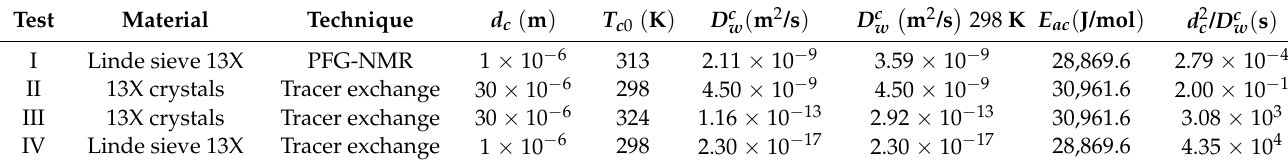
Table 3. Intracrystalline diffusivities for samples with different crystal sizes and average pore diameter of 7.4 Å and values of recalculated D c w at 298 K